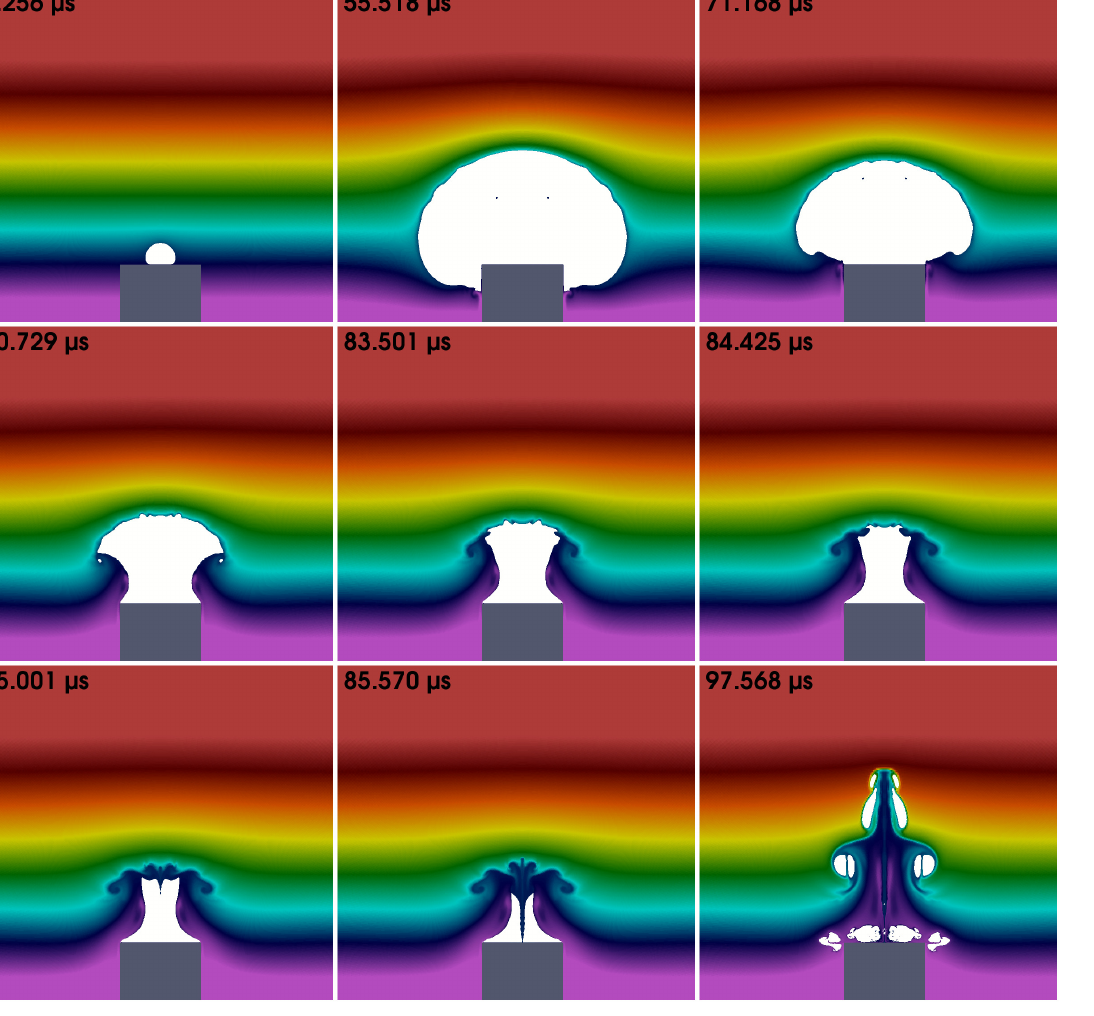
Figure 12. Flow field simulations presented with the help of a warped color layer tracer field of the same bubble and cylinder as in Figure 10. White areas belong to the bubble. Cross sections along the center of axial symmetry. Note the palmette-like flow structure in the last frame. Cylinder radius is 200